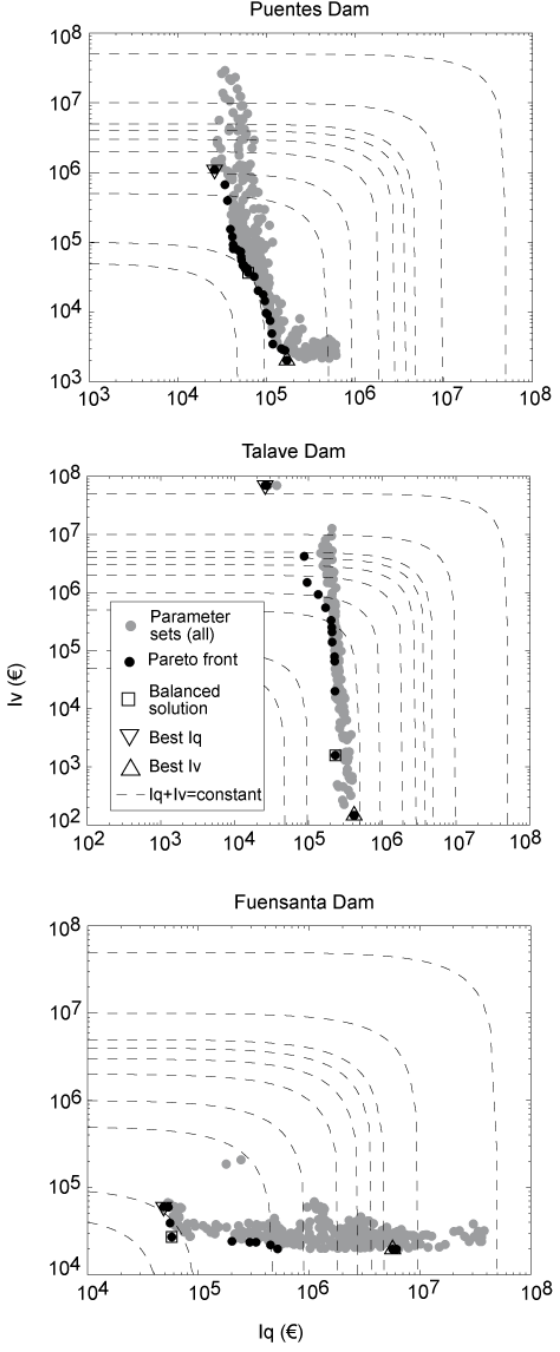
Fig. 10. Behavioural criteria values corresponding to the parameter Figure 10 . Behavioural criteria values corresponding to the parameter sets analysed (grey 807 sets analysed (grey dots) for the three case studies. The black points dots) for the three case studies. The black points correspond to the Pareto front. The square 808 correspond to the Pareto front. The square and triangular symbols and triangular symbols indicate, respectively, the balanced optimum solution and the best 809 indicate, respectively, the balanced optimum solution and the best solutions for each of the two objectives 810 solutions for each of the two objectives.